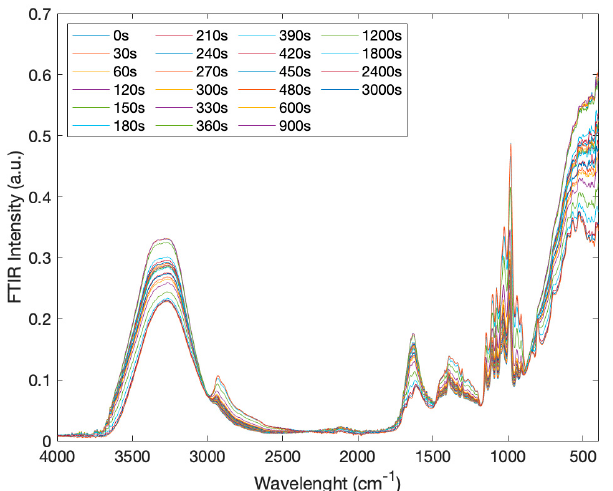
Figure 2. IR Spectra of creatine aqueous solutions in the presence of trehalose as a function of time (0 ÷ 3000 s) in the spectral range of 4000–400 cm − 1 .